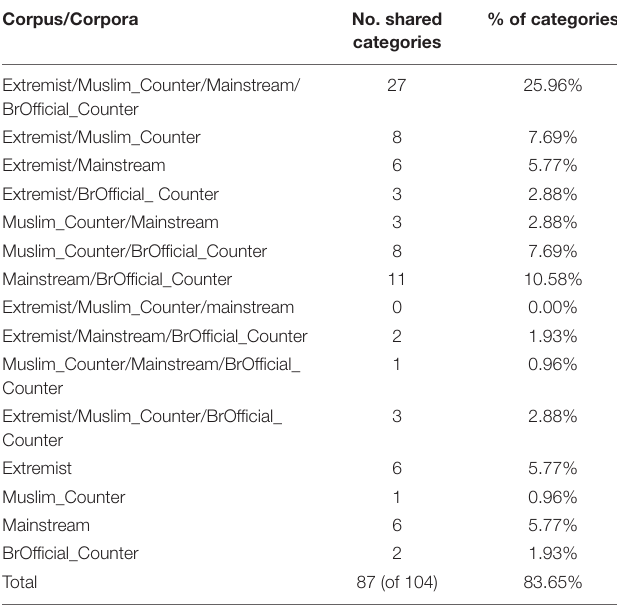
TABLE 5 | Showing numerical breakdown of shared conceptual categories between message types. Corpus/Corpora